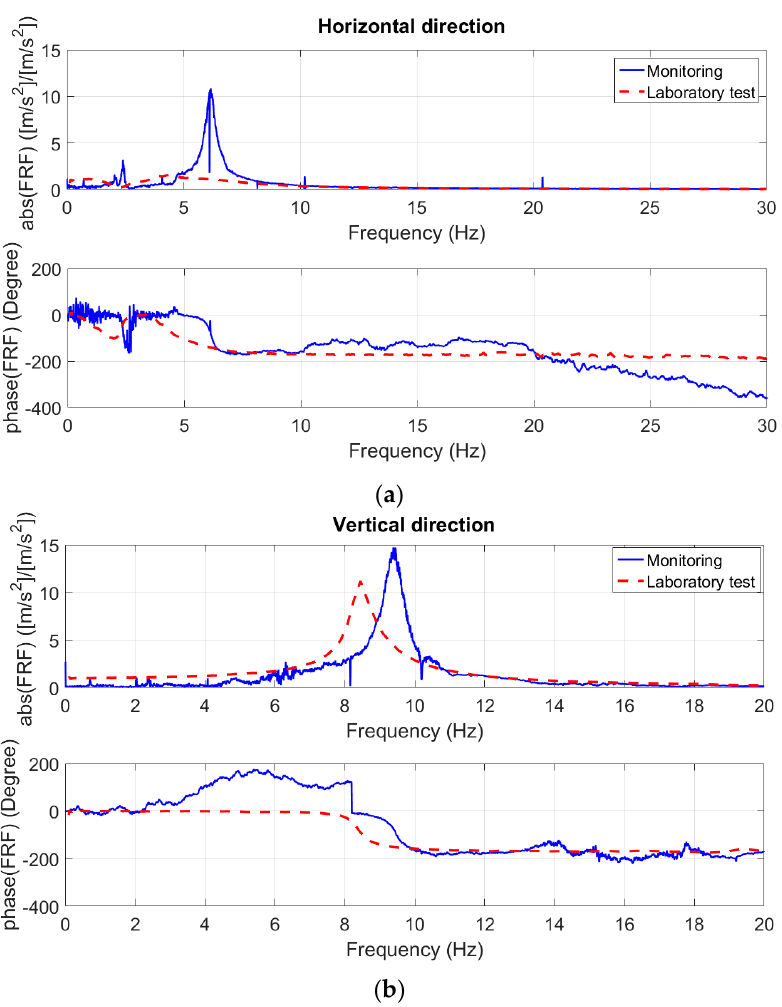
Figure 4. Frequency response functions (FRFs) between the measured points on the seismic plate and the upper plate: in ( a ) horizontal direction; ( b ) vertical direction.